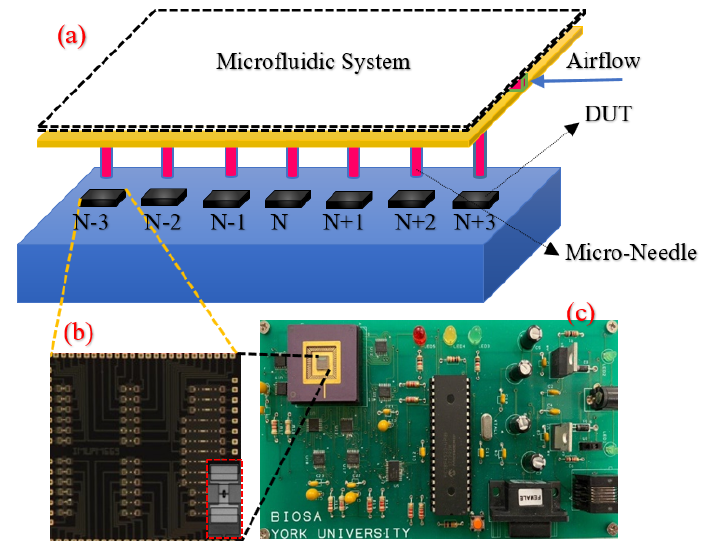
Figure 2. Schematic of Airflow-based Force Manipulation (AbFM) method for testing and characterization of MEMS device under test (DUTs) using aerodynamic forces focusing on movable and elastic components of MEMS die and producing mechanical stimuli to drive and cause dynamic alterations. The DUTs are on a movable nanopositioner, which can move along all three directions, and put DUTs in a specified location under an airflow needle (or microhole) for applying manipulative force with nano-size positioning accuracy.( a ) The general view of proposed system concept ( b ) Represents a fabricated microcantilever MEMS die as a volunteer for airflow-based testing methods. (b)-inset A single microcantilever (zoomed in) in the chip. ( c ) Readout interface system. N is the label of the n th die under test.